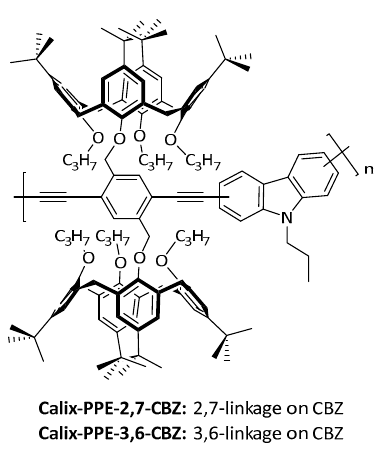
Chart 1. Chemical structure of Calix ‐ PPE ‐